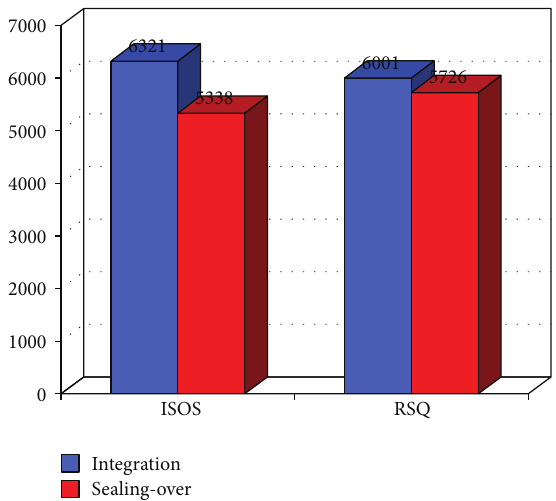
Figure 1: Comparison of average incurred costs for patients with different recovery style. The blue bar represents integrator sub- jects while the red bar represents sealing-over subjects. Integrator patients are provided with superior annual performance compared to sealing-over patients. Costs are expressed in Euros.